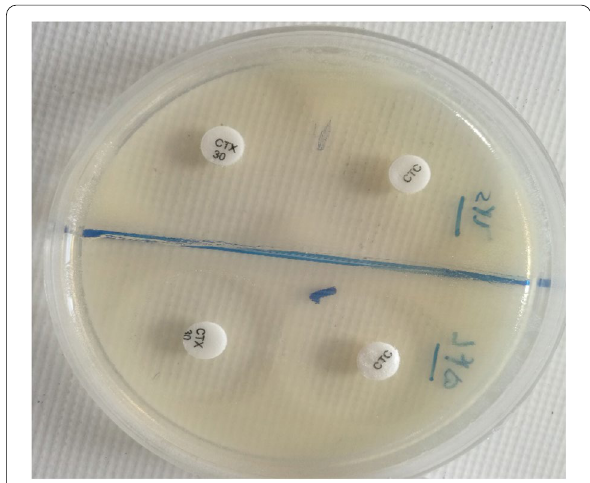
Fig. 3 Phenotypic detection of ESBL-producing isolate using double disc test. The synergy between cefotaxime (CTX) and cefotaxime- clavulanate (CTC) is